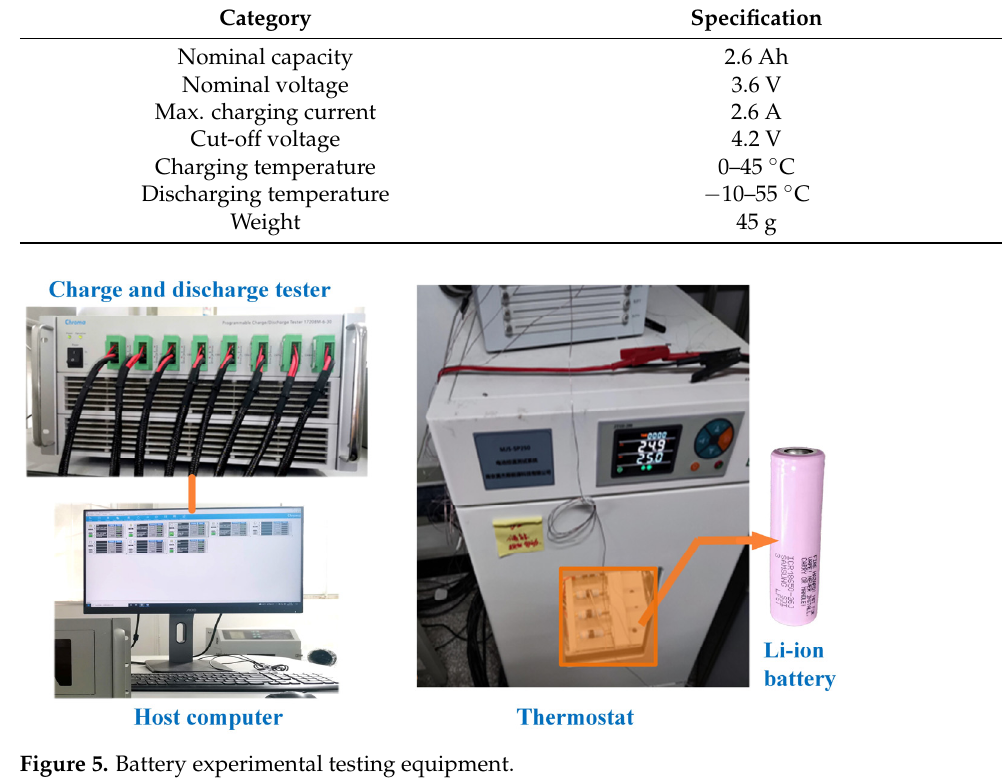
Table 3. ICR18650-26J battery specifications.